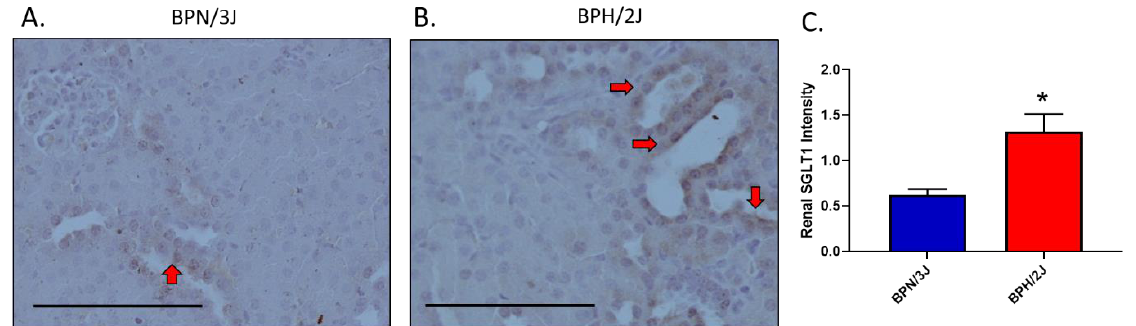
Figure 3. Hyperactivation of the SNS promotes upregulation of SGLT1 protein levels in the kidneys of neurogenically hypertensive BPH/2J mice. Representative SGLT1 immunohistochemistry images of renal tissue of ( A ) normotensive mice or ( B ) neurogenically hypertensive mice ( C ) Quantitation of SGLT1 intensity. * p = 0.037; data represented as mean ± SEM; n = 3 – 5/group. Red arrows = luminal SGLT1 expression; Bar = 100 μ m; SGLT1, Sodium glucose cotransporter 1.